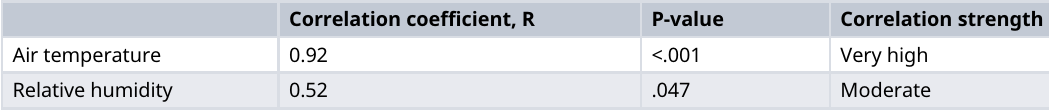
Table 6. Correlation strength of lightning strikes with air temperature and relative humidity in